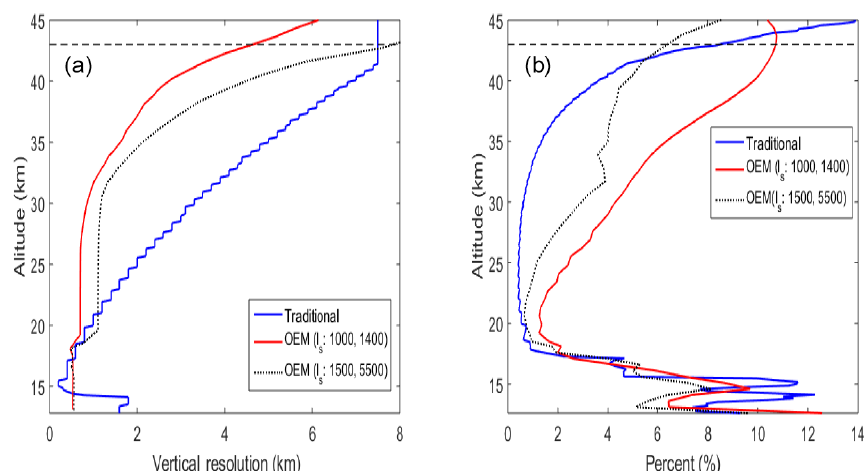
Figure 5. (a) The vertical resolution of the OEM with correlation lengths (cid:96) s = 1000 and 1400m (red curve) is plotted against the vertical resolution of the OEM with correlation lengths (cid:96) s = 1400 and 5500m (black dotted curve). The vertical resolution of the traditional method is shown as well (blue curve). (b) The statistical uncertainty of the OEM with correlation lengths (cid:96) s = 1000 and 1400m is plotted (red curve) against the statistical uncertainty of the OEM with correlation lengths (cid:96) s = 1400 and 5500m (black dotted curve). Additionally, the uncertainty of retrieval in the traditional method (blue curve) is plotted. The retrieval uncertainties in the OEM and the traditional method can be compared. The horizontal dashed line is a height below which the OEM retrieval is more than 80% due to the measurements.